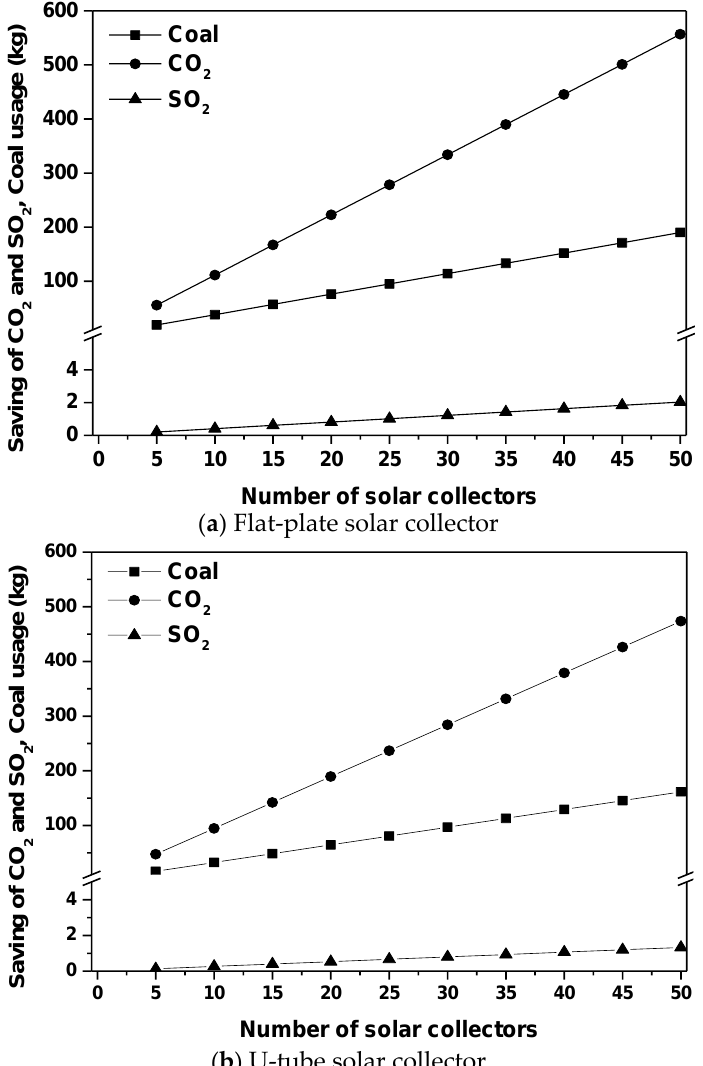
Figure 5. Coal use and CO 2 and SO 2 savings depending on the number of solar collectors (Al 2 O 3 size: 20 nm, concentration: 1.0 vol %): ( a ) Flat-plate solar collector; ( b ) U-tube solar collector.